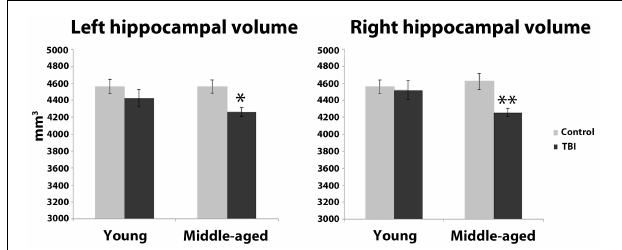
FIGURE 3 | Hippocampal volume differences as a function of the combination of distal mTBI and aging. ∗ p < 0 . 05, ∗∗ p < 0 . 01; error bars are ± one standard error of the mean.